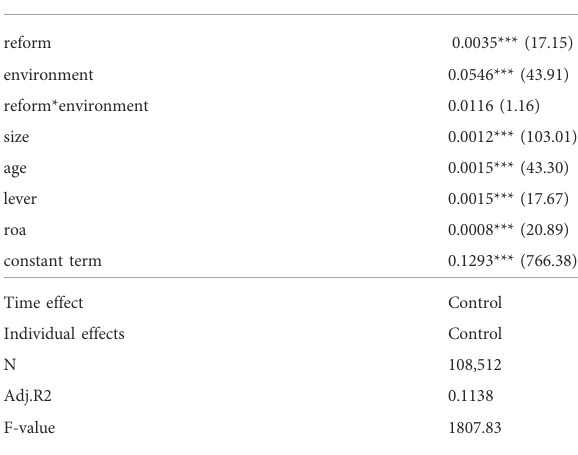
TABLE 9 Results of the test for moderating